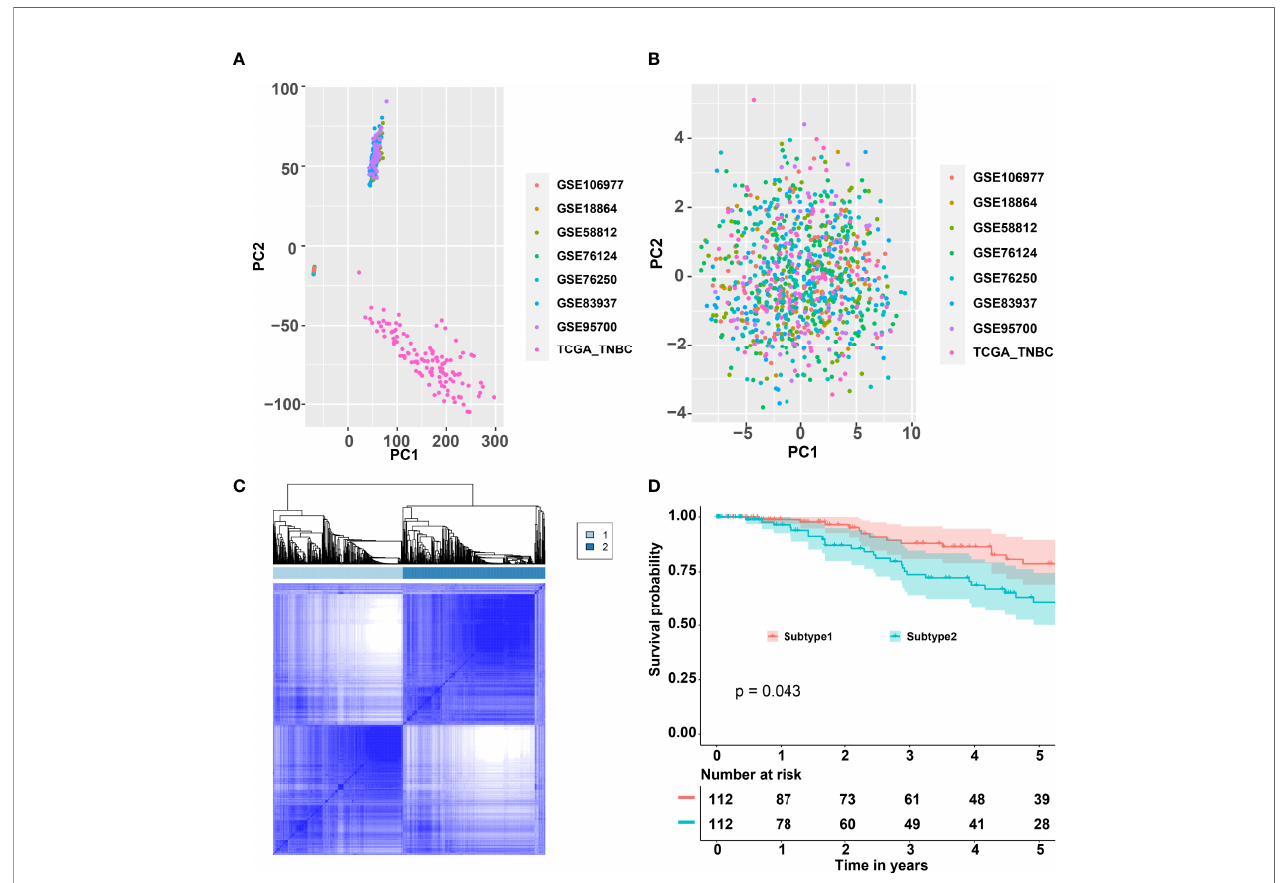
FIGURE 2 | Consensus clustering for the TNBC by combining eight datasets GSE18864, GSE58812, GSE76124, GSE76250, GSE83937, GSE95700, GSE106977, and TCGA. (A) PCA of the expression matrix of eight different datasets. (B) PCA of the levels of the immune cells of eight different datasets. (C) Consensus matrix heatmap plots when k = 2. (D) Five-year Kaplan – Meier curves for OS of TNBC patients strati fi ed by the immune subtypes. p -value was calculated by the log-rank test among subtypes. TNBC, triple-negative breast cancer; PCA, principal component analysis; TCGA, The Cancer Genome Atlas; OS, overall